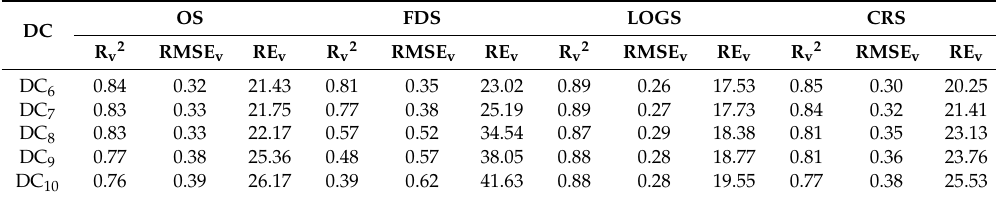
DC i denotes the detail coe ffi cient (DC) at L i